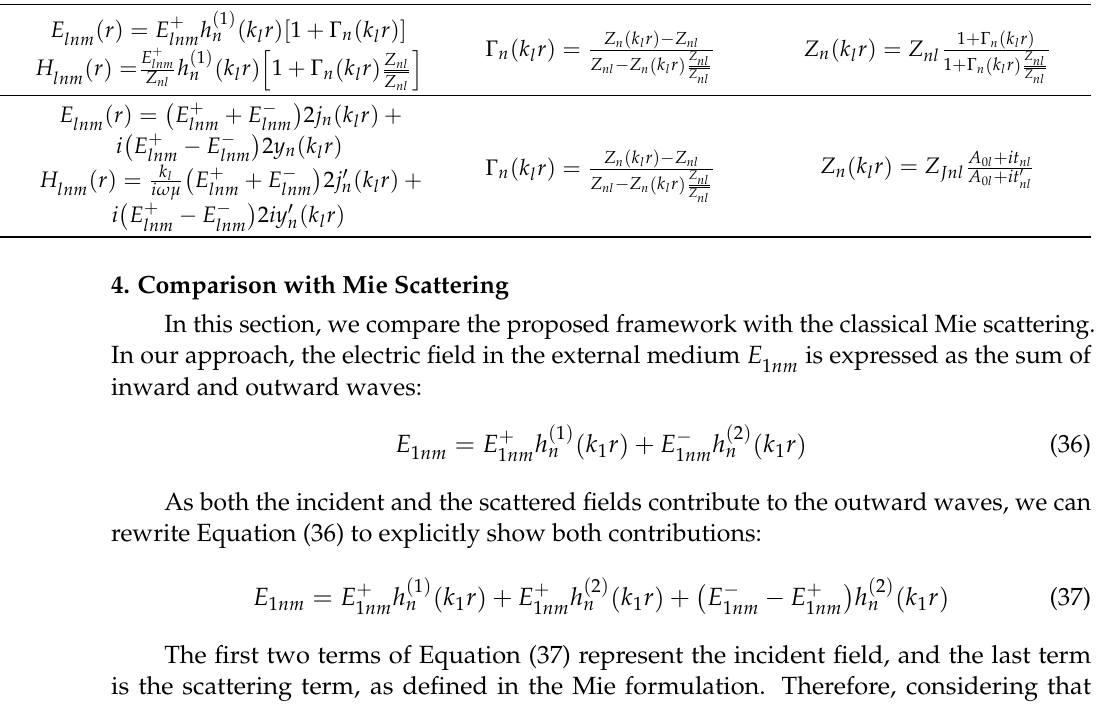
Table 2. Summary of the formulas defining the proposed framework. Electromagnetic Field Reflection Coefficient